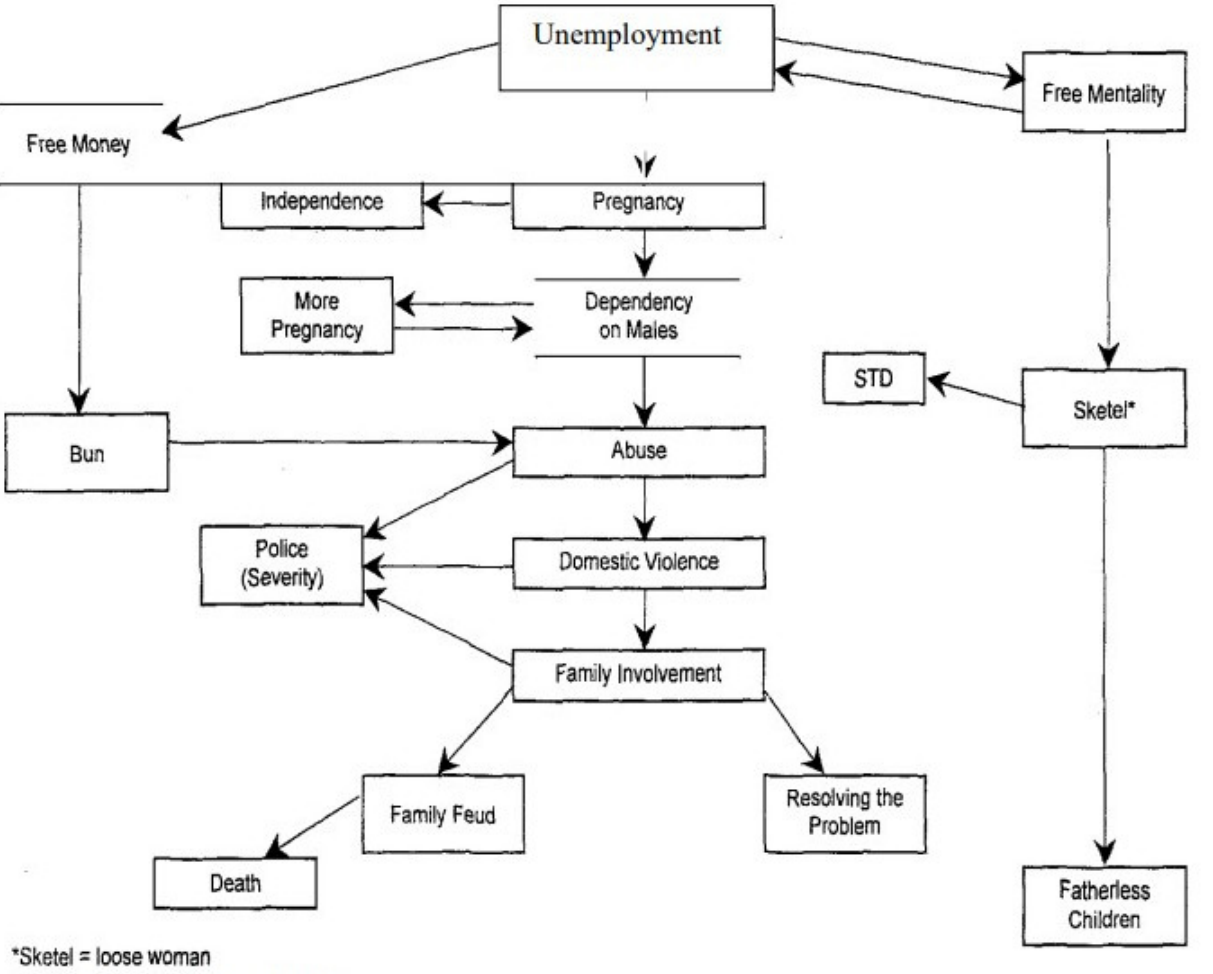
Figure 2. The Problem of Unemployment and Its Impact on Women (Diagram prepared by a group of young women from Park Town in Kingston, Jamaica)